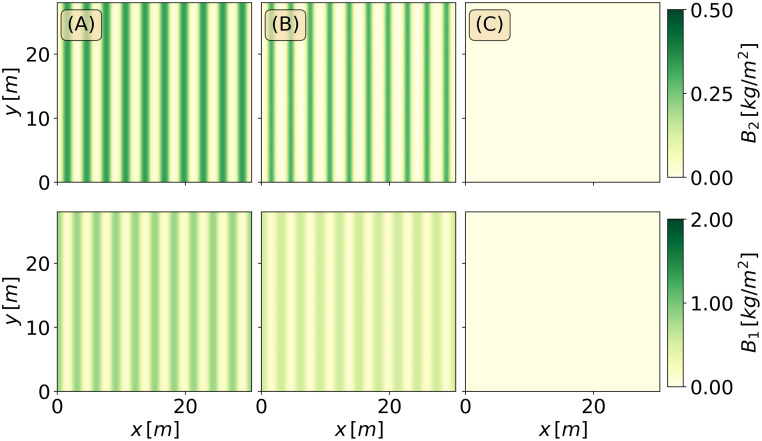
Precipitation downshift for the stripes patterns.Time integration of the stripes patterns for a downshift of the mean annual precipitation from P = 600mm/y (in (A)), to P = 400mm/y (in (B)), and to P = 200mm/y (in (C)), over a period of T = 100y.